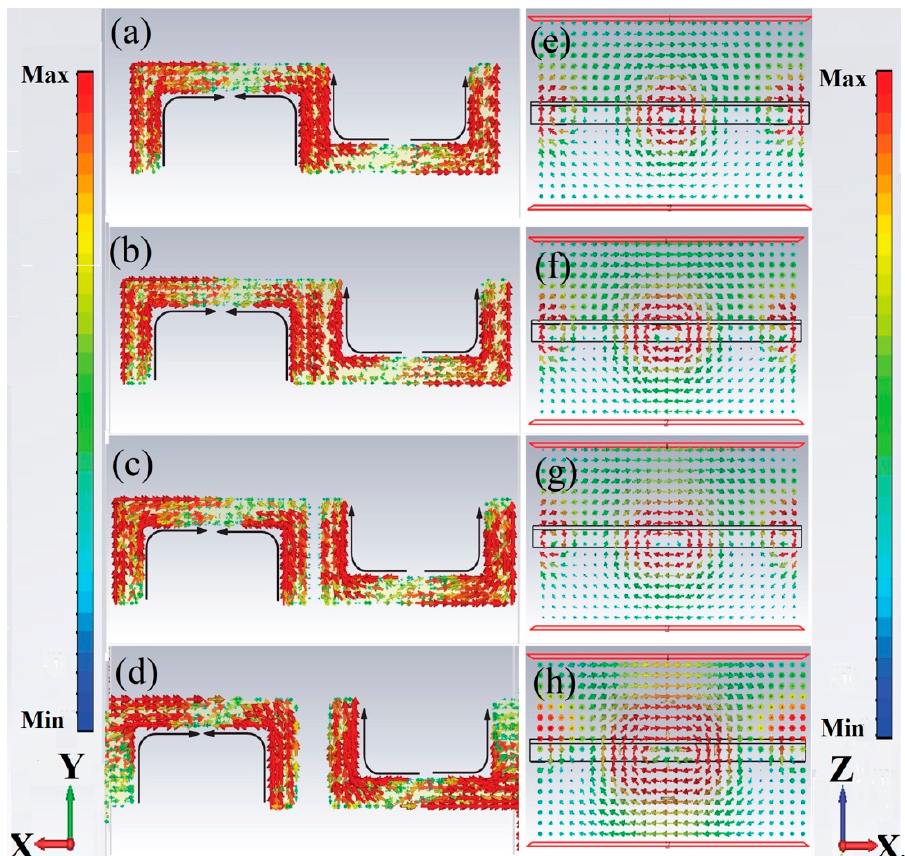
Figure 6. Simulated surface currents ( a – d ) and magnetic field (on XZ plane at Y = 0 ( e – h )) of resonator at high frequency resonances.